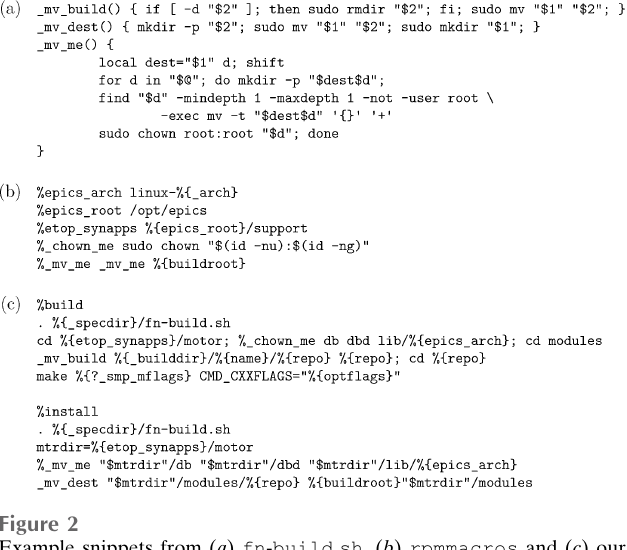
Figure 2 Example snippets from ( a ) fn - build : sh , ( b ) rpmmacros and ( c ) our